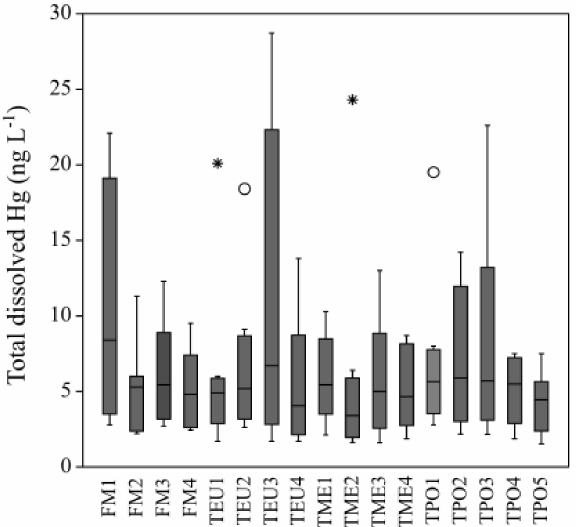
Figure 4. Total dissolved Hg in the water bodies of the Marano and Grado Lagoons. The box and whisker plot representation was used to display the median, 25th and 75th percentiles and the presence of outliers. The whiskers are drawn from the top of the box up to the largest data point less than 1.5 times the box height from the box (the “upper inner fence”), and similarly below the box. Values outside the inner fences are shown as circles, values further than 3 times the box height from the box (the “outer fences”) are shown as